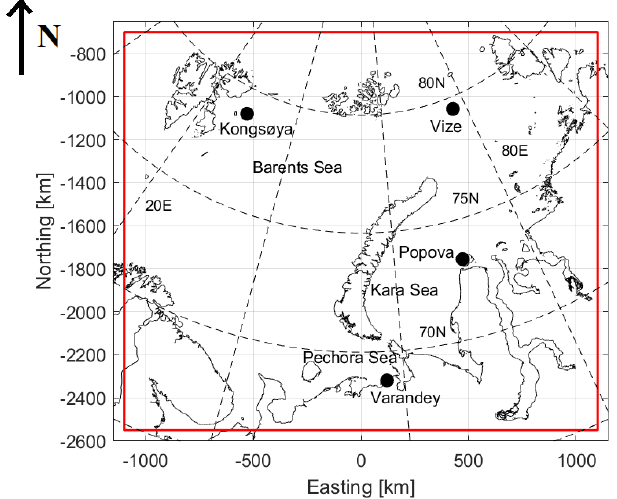
Figure 2. The Barents Sea and Kara Sea study area in the used po- lar stereographic projection. Air temperature data from four coastal weather stations shown with black dots are used in this study. © FMI.